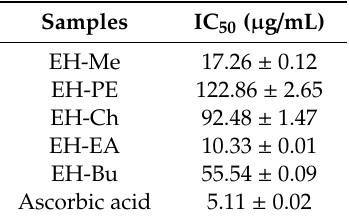
Table 4. 2,2-diphenyl-1-pycrylhydrazyl (DPPH) radical scavenging activity of extracts. Samples